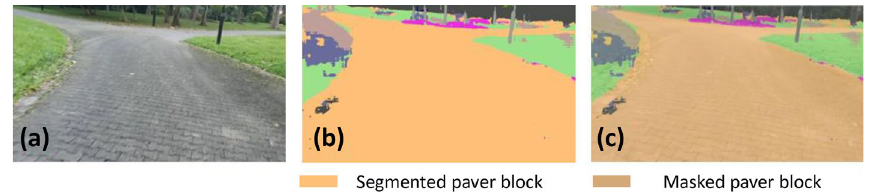
Figure 20. Online results: paver block.